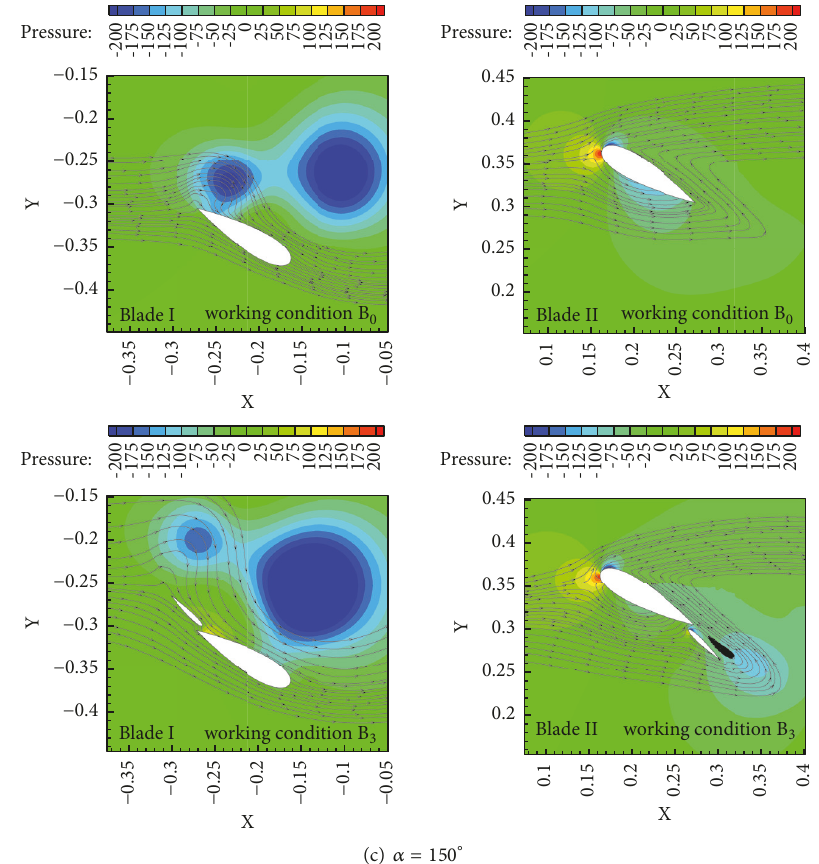
Figure 10: Streamline and pressure contours around wind turbine blade of working condition